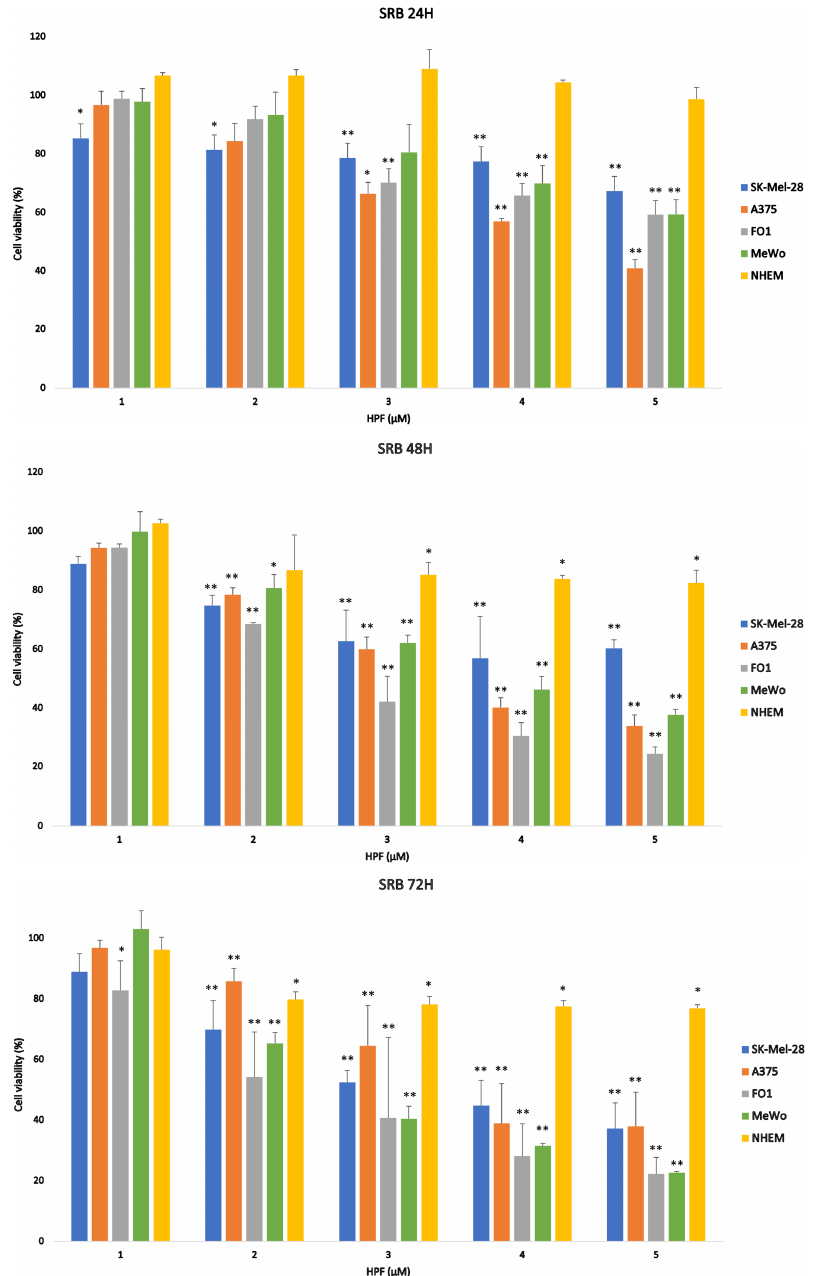
Figure 1. Histograms show time- and concentration-dependent reduction in cell viability after hy- perforin treatment. SRB cell viability assay was performed on A375 (orange), FO-1 (grey), SK-Mel- 28 (blue) and MeWo (green) melanoma cells treated with 1 to 5 µM hyperforin (HPF) for 24, 48 and 72 hours. HPF induced a time- and concentration-dependent decrease in cell viability, in compari- son with untreated cells (100%). Normal human epithelial melanocytes (NHEM, yellow), treated with HPF for 24, 48 and 72 hours, was shown to be less affected by HPF than melanoma cells. Data acquired calculating the average ± S.D. of values obtained from at least four independent experi- ments were compared with the untreated control (* p < 0.05; ** p < 0.01).